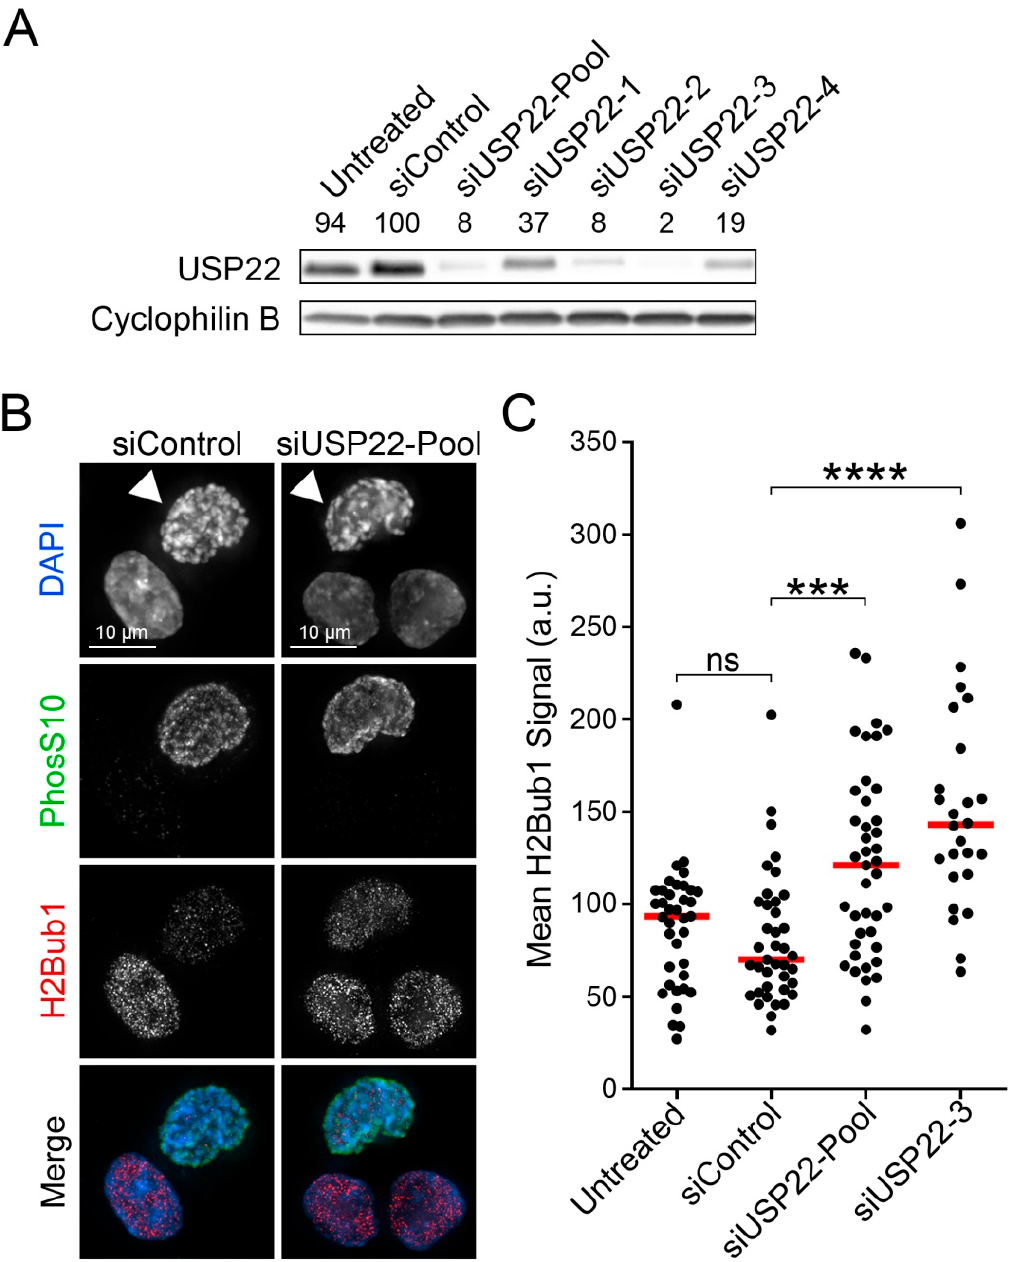
Figure 1. USP22 silencing induces increases in global H2Bub1 levels in prophase cells. ( A ) Western blot presenting USP22 abundance following silencing in HCT116 with either individual (siUSP22-1, -2, -3 and -4) or pooled USP22 (siUSP22-Pool) siRNAs and controls (untreated or siControl); cyclophilin B serves as the loading control. Semi-quantitative analyses were performed and the normalized USP22 levels are presented relative to siControl (100%). ( B ) Representative high-resolution 3D images (maximal intensity projection) of prophase HCT116 cells (arrowheads) immunofluorescently labeled for PhosS10 and H2Bub1 following silencing. For quantitative purposes, all images were acquired using identical exposure times. ( C ) Dot plot presenting the mean H2Bub1 signal intensity/cell, with red bars identifying median signal intensities. Mann–Whitney tests identify significant increases in mean H2Bub1 intensities (i.e., protein expression levels) following USP22 silencing relative to siControl (N = 2; n > 25 cells/condition; ns p -value > 0.05; *** p -value < 0.001; **** p -value < 0.0001).